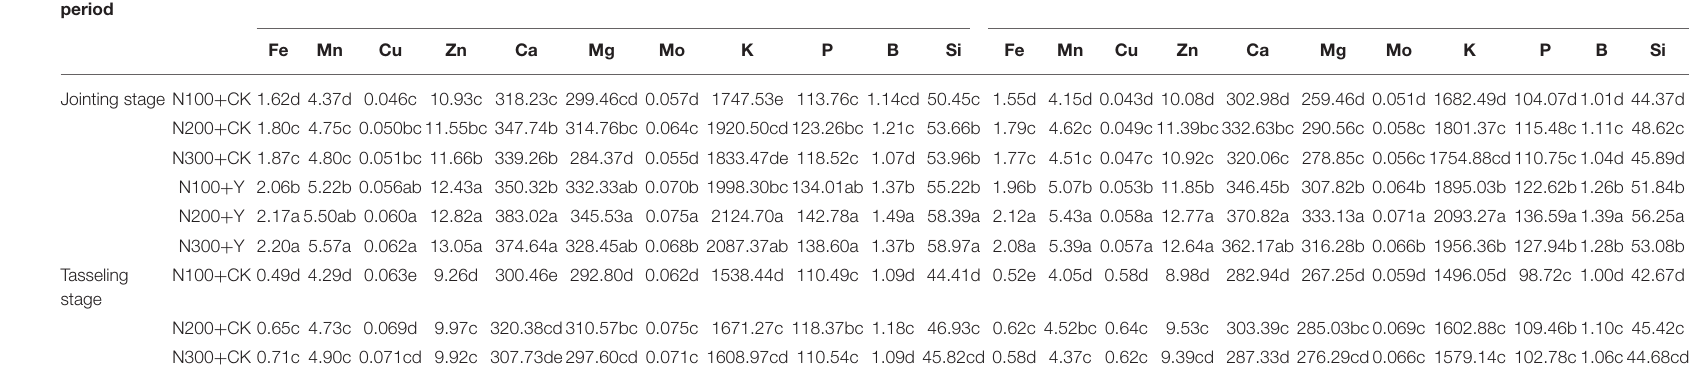
TABLE 3 | Effects of chemical control and nitrogen fertilizers on mineral nutrients concentrations ( µ g h − 1 plant − 1 ) in root-bleeding sap during the maize growing period in 2017 and 2018. Growth